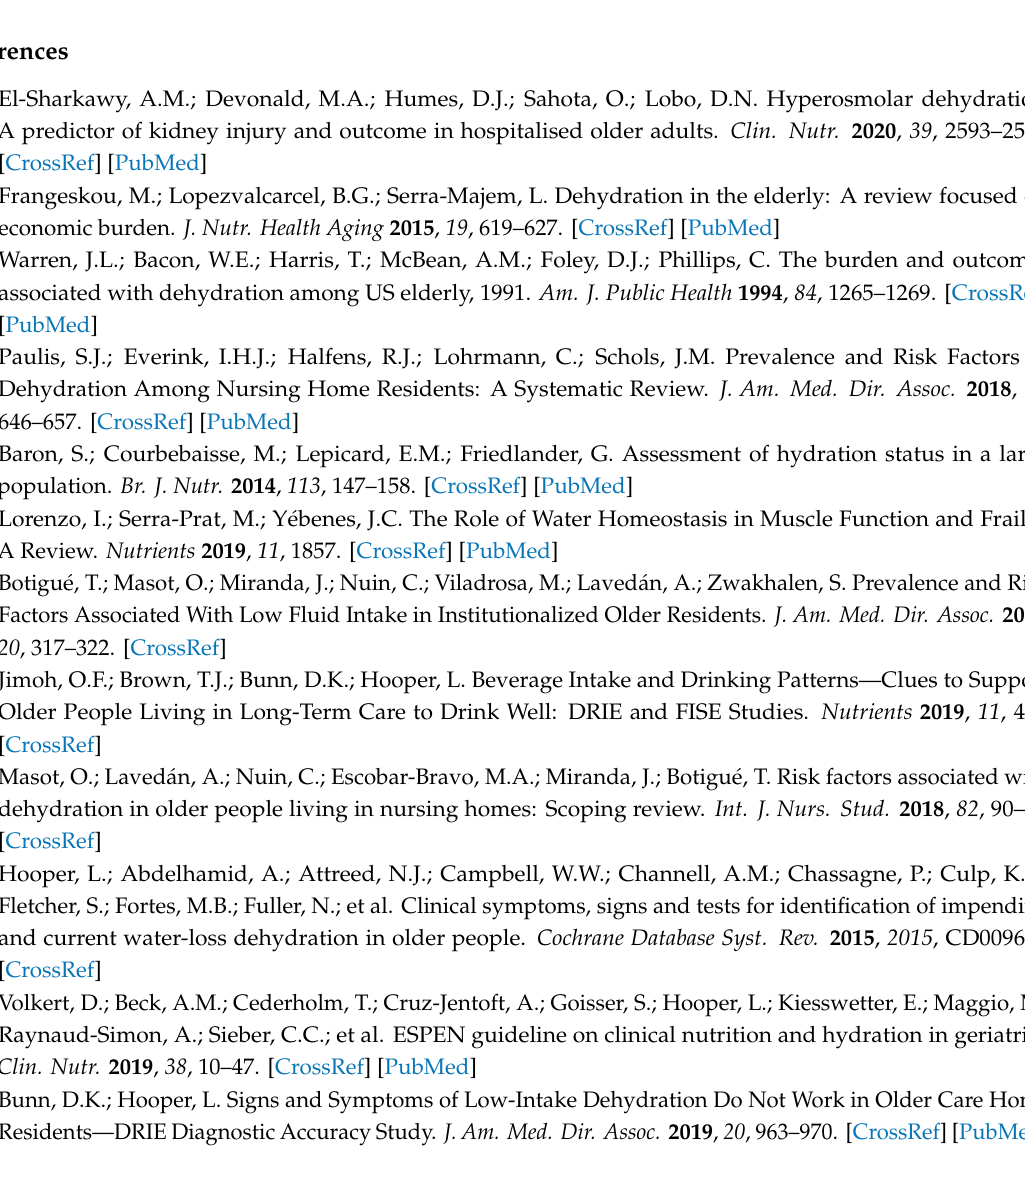
Table S1: Correlation coe ffi cient between eGFR and BMI (Pearson’s correlation